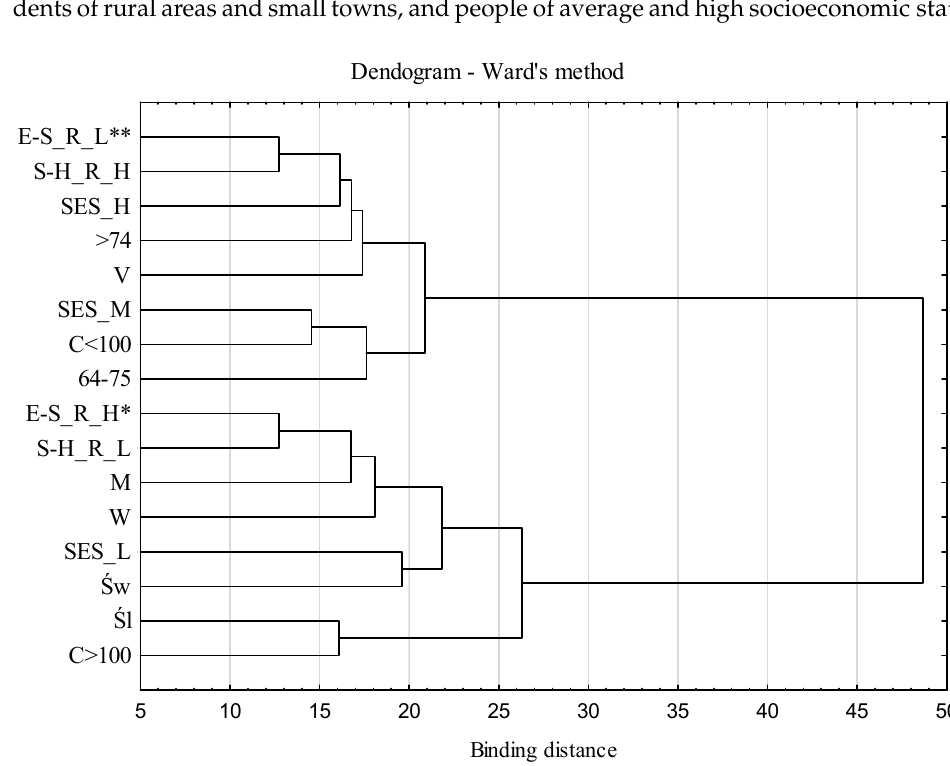
Figure 1. Dendogram showing the hierarchical classification of variables describing reasons for food insecurity, demographic characteristics, and socioeconomic status of respondents. * relationship be- tween E-S_R_H—“economic and social” reasons of high importance, S-H_R_L—“spatial and health” reasons of low importance, W—women, M—men, Ś w— ś wi ę tokrzyskie region, Ś l— ś l ą skie region, C > 100—a city with more than 100.000 inhabitants, SES_L—low socioeconomic status. **